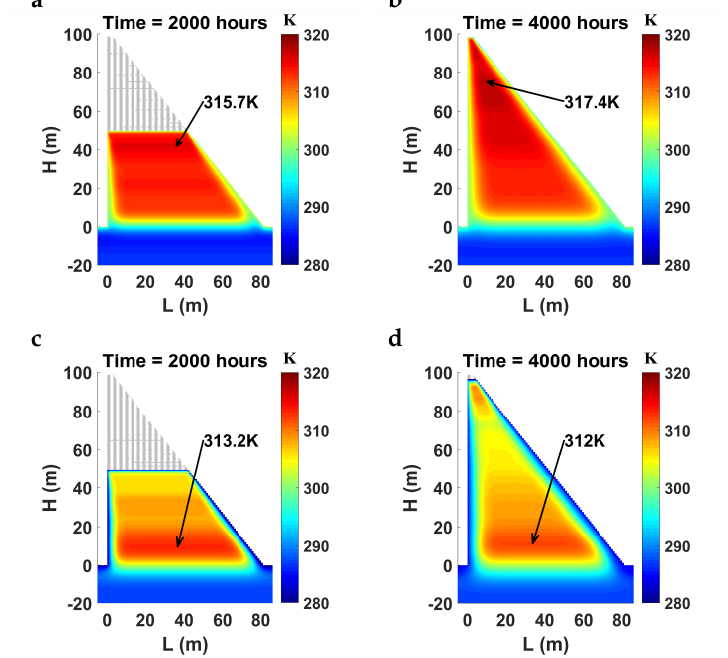
Figure 7. Here we illustrate the influences of the construction start date and the hydration model. We have simulated the construction of two RCC dams starting on April, 2014—spring, and October, 2014—autumn. The hydration reaction is computed with the NAH model. We plot the thermal field of the dam built in spring at mid-height in panel ( a ) and that at the end of the construction in panel ( b ). The thermal field of the dam built in autumn at mid-height is depicted in panel ( c ) and that at the end of construction in panel ( d